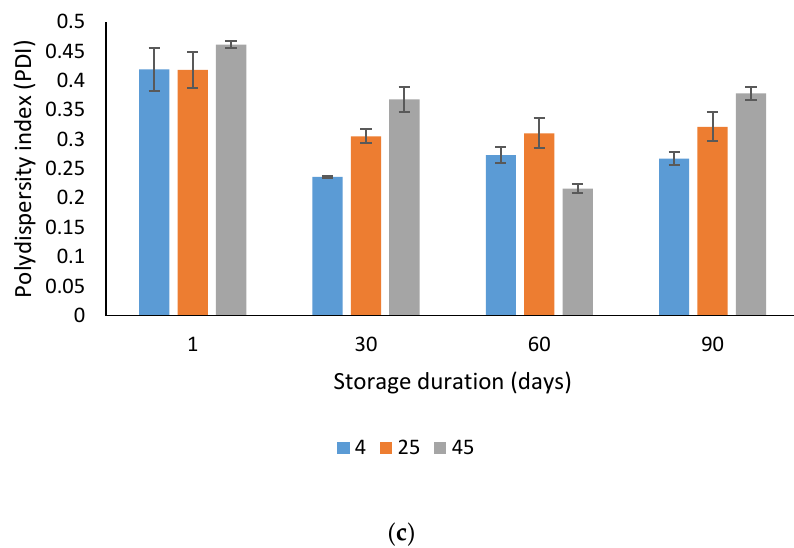
Figure 4. Physical stability of the optimized nanoemulsion containing KMO in terms of ( a ) droplet size; ( b ) zeta potential; ( c ) polydispersity index (PDI).